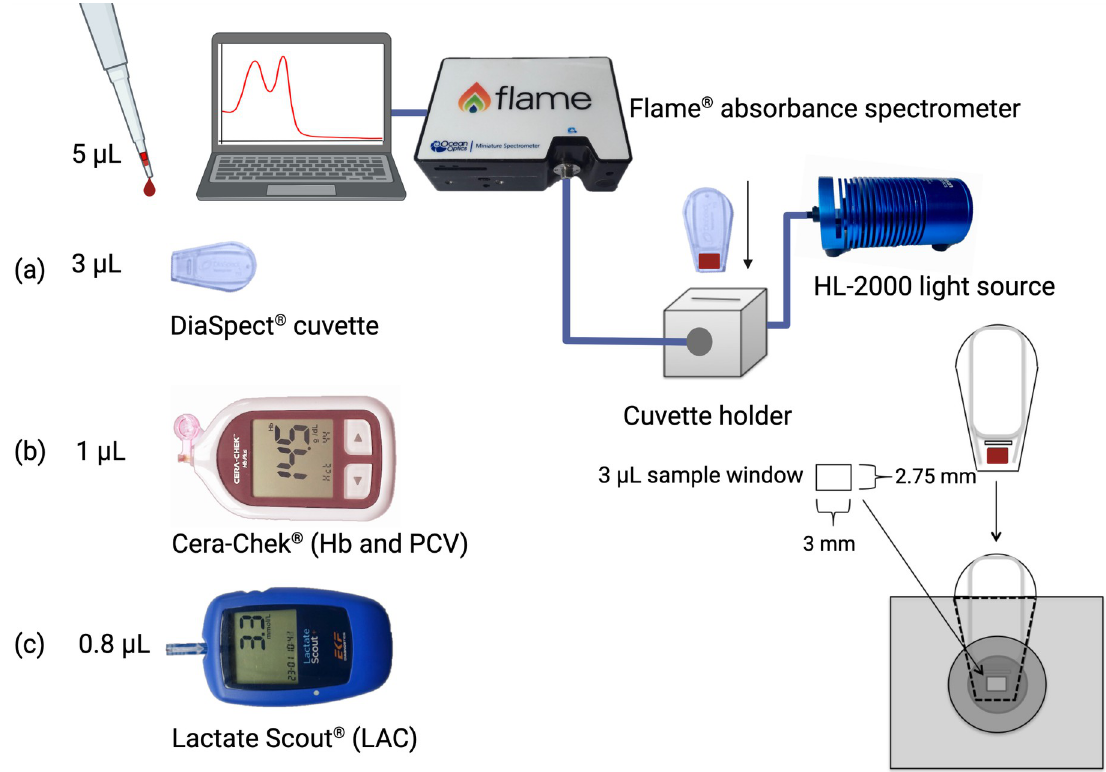
Fig 1. A 5 μ L whole blood sample was apportioned to (a) the DiaSpect plastic cuvette (3 μ L) and placed in a customised holder with SMA 905 connectors for the optical fibre terminators for the Flame absorbance spectrometer (Ocean Optics: Largo, USA). Another 1 μ L of whole blood (b) was pipetted to the biosensor of the Cera-Chek total haemoglobin (Hbt) and packed cell volume (PCV) point-of-care monitor. Lactate (LAC) was measured using the (c) Lactate Scout (EKF diagnostics, Germany) by pipetting between 0.5–0.8 μ L of whole blood onto the